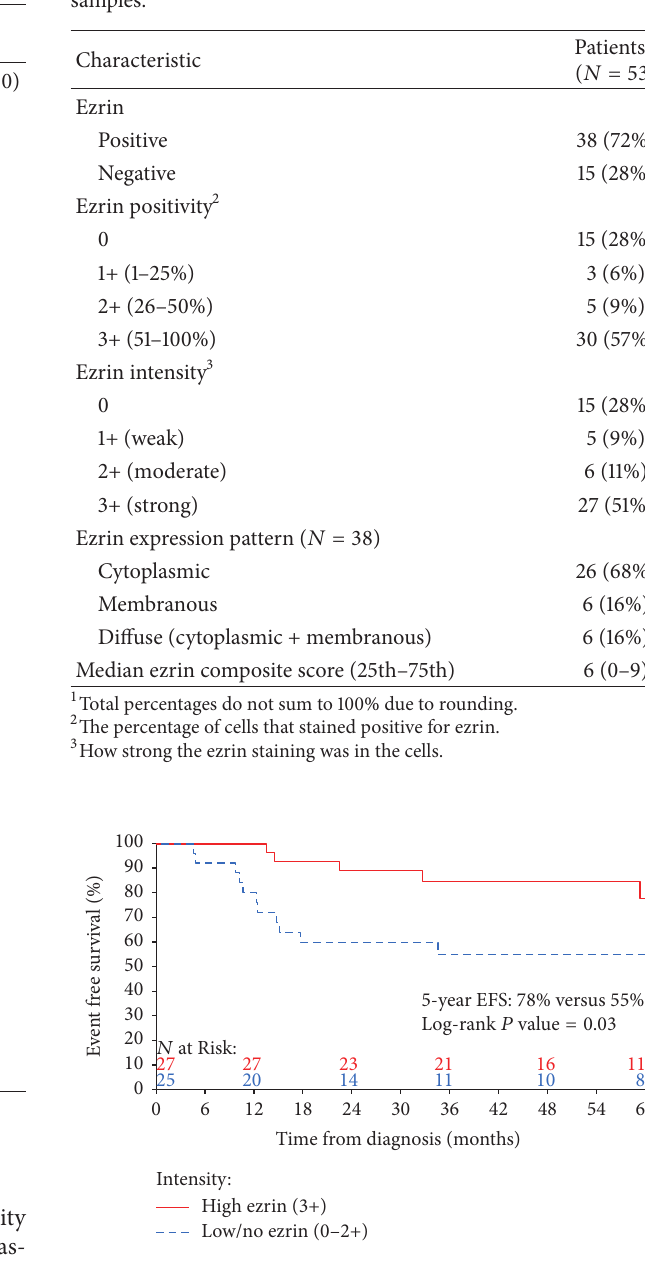
Figure 2: Kaplan-Meier estimates of 5-year event-free survival (EFS) for patients with tumors with high versus low/no ezrin